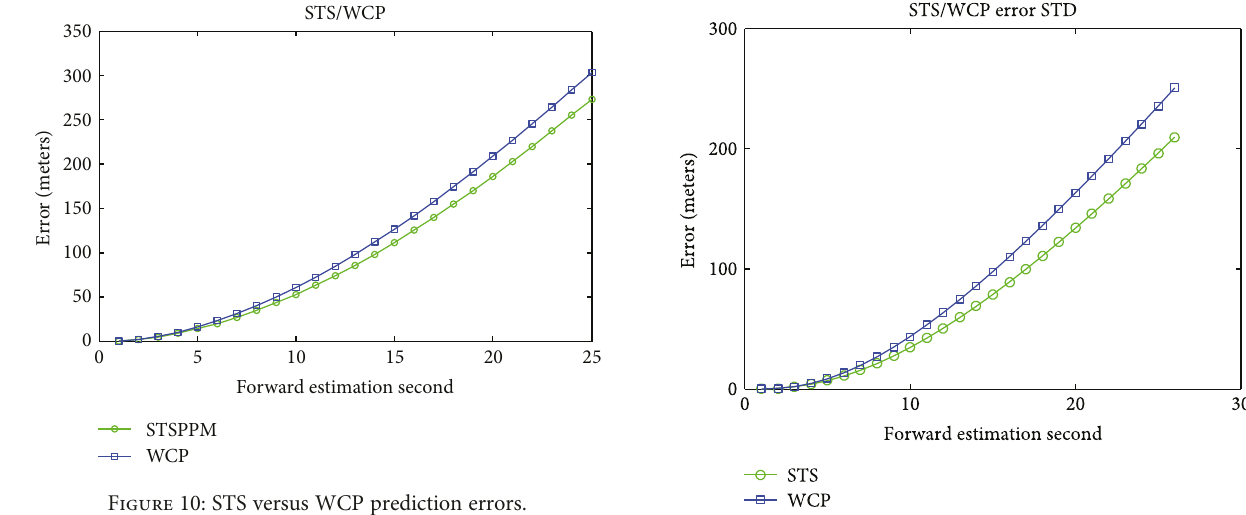
Figure 12: STS versus WCP prediction STD.